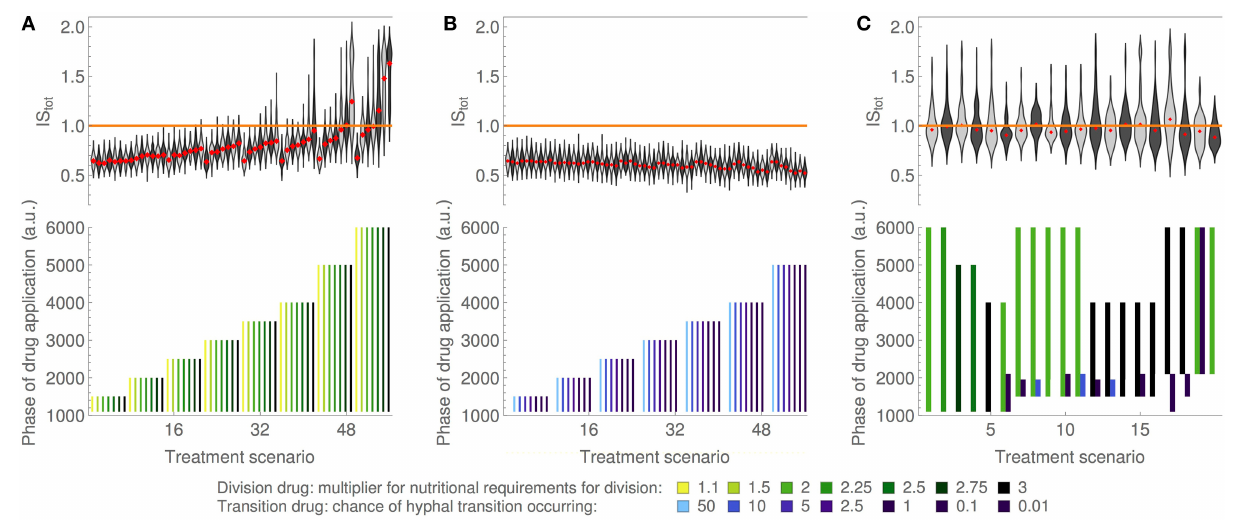
FIGURE 4 | Simulation of the model upon drug treatments. Efficiency of drug treatment scenarios in terms of infection score. The distribution of infection scores IS total is indicated by violin plots in the top panels, with the median marked in red and the optimal value of 1 indicated by a horizontal orange line. Respective treatment scenarios are indicated in the bottom panels, indicating treatment duration by bar length and dosage by bar coloring. C. albicans infection was always induced by the application of MD (starting at t = 1000 ts , ending at t = 2000 ts ). (A) Analysis of the DD efficiency. Only when longer treatment was applied the system was more likely to recover from the infection by t = 7000 ts . An increased drug dosage introduced variability to the drug performance. (B) Analysis of the TD efficiency. Irrespective of the drug dosage and duration, the system was never able to recover from the simulated fungal infection indicating low effectiveness of the TD. (C) Analysis of the combinatorial DD and TD treatments. Successful treatment strategies were tested by scoring the performance of DD and TD as a multi-drug treatment. Presented are the top 20 treatments scenarios for which median IS total values were close to 1 (see Table 2 for parameters). The remaining treatment scenarios tested are listed in Supplementary Table 2. Addition of TD to DD treatment has a synergistic effect. Complementation with TD decreased the IS total variability and improved the median IS total value when compared to the performance of DD alone with the same dose and duration (compare e.g., treatment scenarios 5 and 6, or 8 and